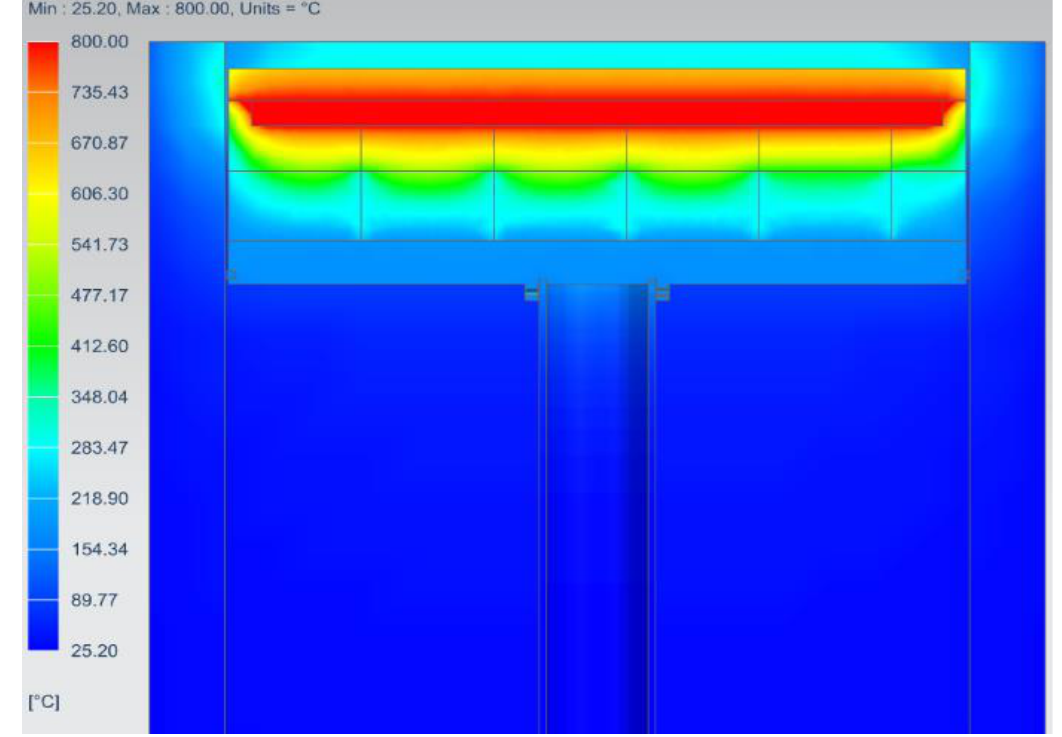
Figure 19. Thermal analysis results of the HeatGenPro Concept.